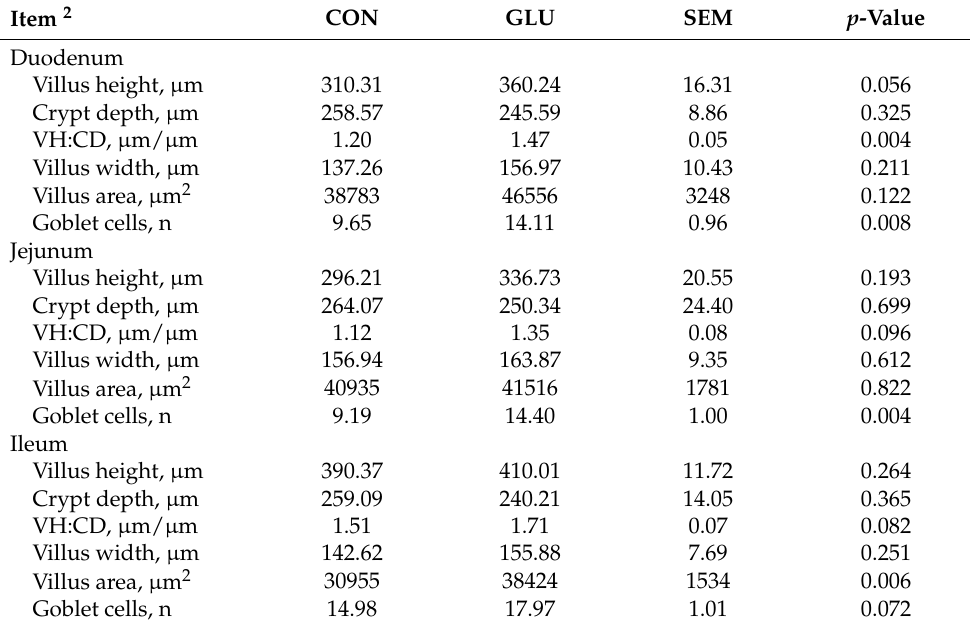
Table 5. Effects of dietary treatments on intestinal morphology of weaned pigs 1